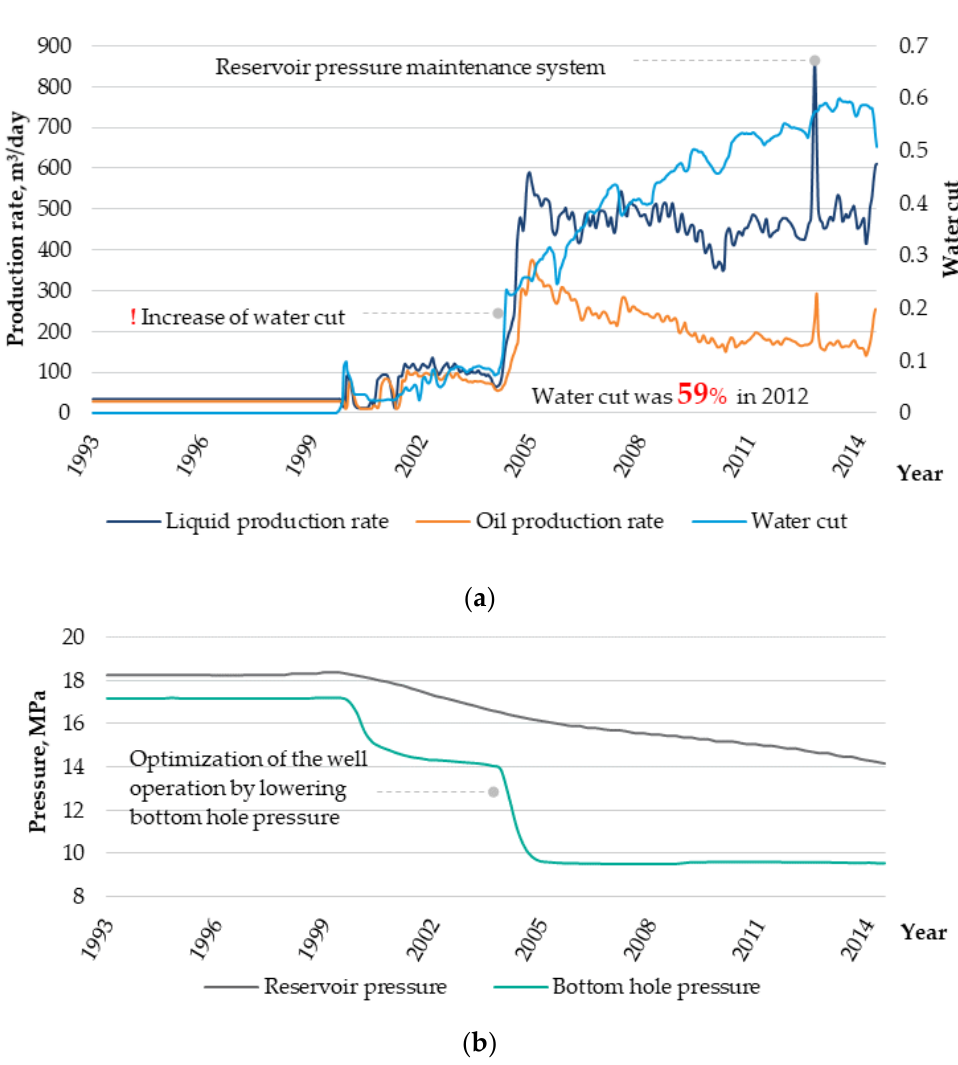
Figure 4. ( a ) Production performance of the field under consideration [3]; ( b ) Pressure history of the field under consideration [3].